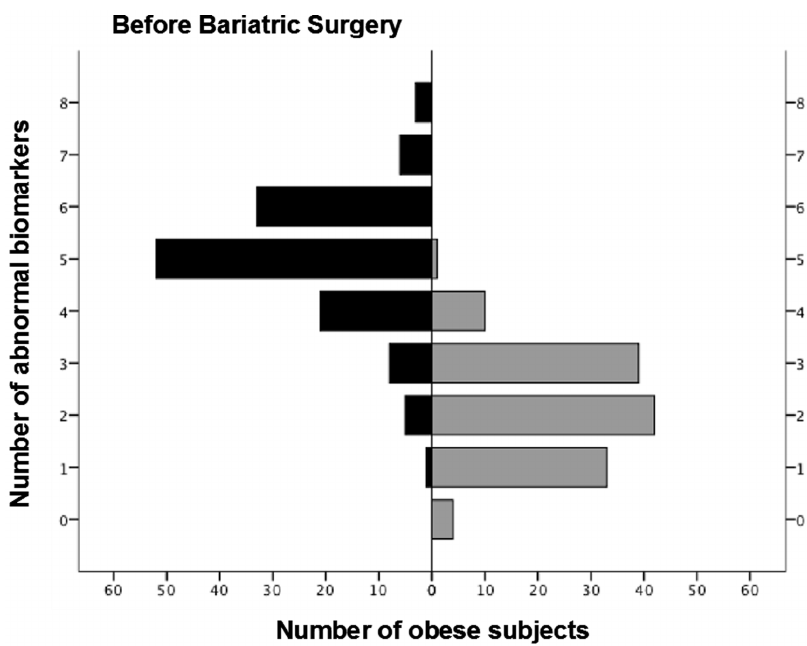
Figure 1. Frequency distribution of obese individuals according to the number of abnormal systemic (serum) biomarker values ( . 95 th percentile of controls (or , 5 th percentile in the case of adiponectin), before and after BS.